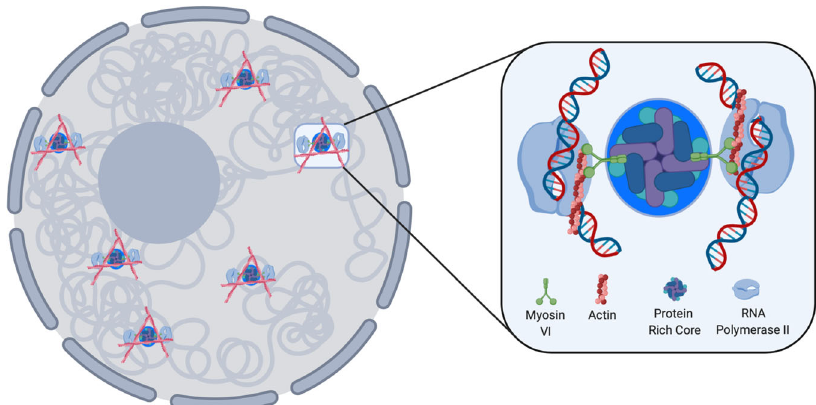
Fig. 9 Schematic of myosin VI anchoring RNAPII at transcription factories. Based on the data presented here we can propose this model for RNAPII clustering. Transcription sites within the nucleus are marked by clustering of RNAPII and actin fi laments. Focusing on the clusters: The protein rich core consists of transcription regulators which the DNA would also contact. MVI interacts with these proteins and DNA via its C-terminal domain. MVI then interacts with RNAPII through nuclear actin fi laments thereby providing the framework for mechanical linkage to